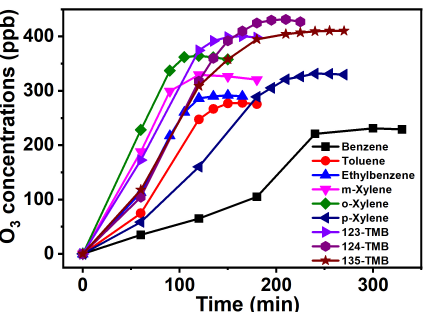
Figure 2. O 3 formation curve from AH photochemical oxidation with the presence of NO x (2000ppb of benzene and 160.2ppb of NO x , 1048 ppb of toluene and 162.0ppb of NO x , 1050ppb of ethylbenzene and 162.4ppb of NO x , 889ppb of m -xylene and 172.1ppb of NO x , 1052ppb of o -xylene and 159.8ppb of NO x , 1040ppb of p -xylene and 157.2ppb of NO x , 956ppb of 123-TMB and 171.4ppb of NO x , 1010ppb of 124-TMB and 169.5ppb of NO x , 1040ppb of 135-TMB and 164.2ppb of NO x ).